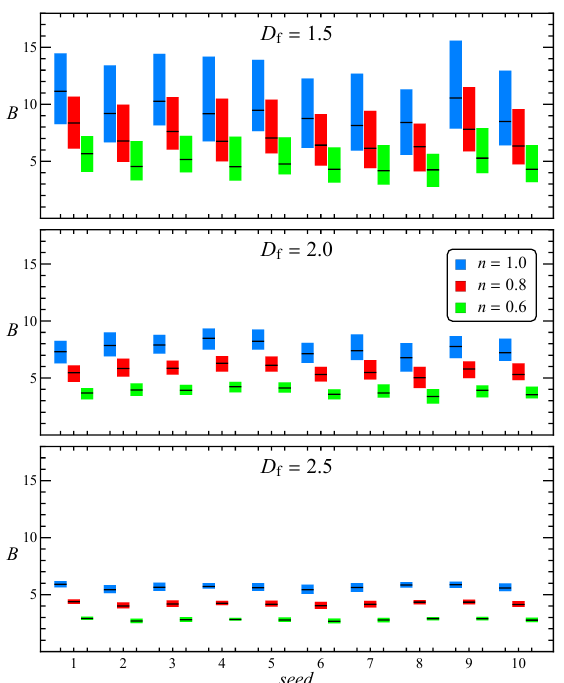
Figure 3. Box plot of the intrinsic viscosity as a function of aggregate random seed, flow index and fractal dimension. The black dash within each box represents the median of the